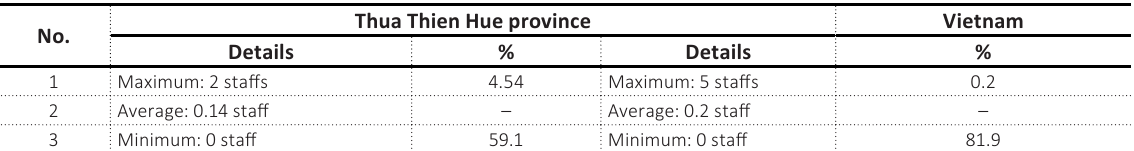
Table 3. Staffing for digital marketing in handicraft businesses